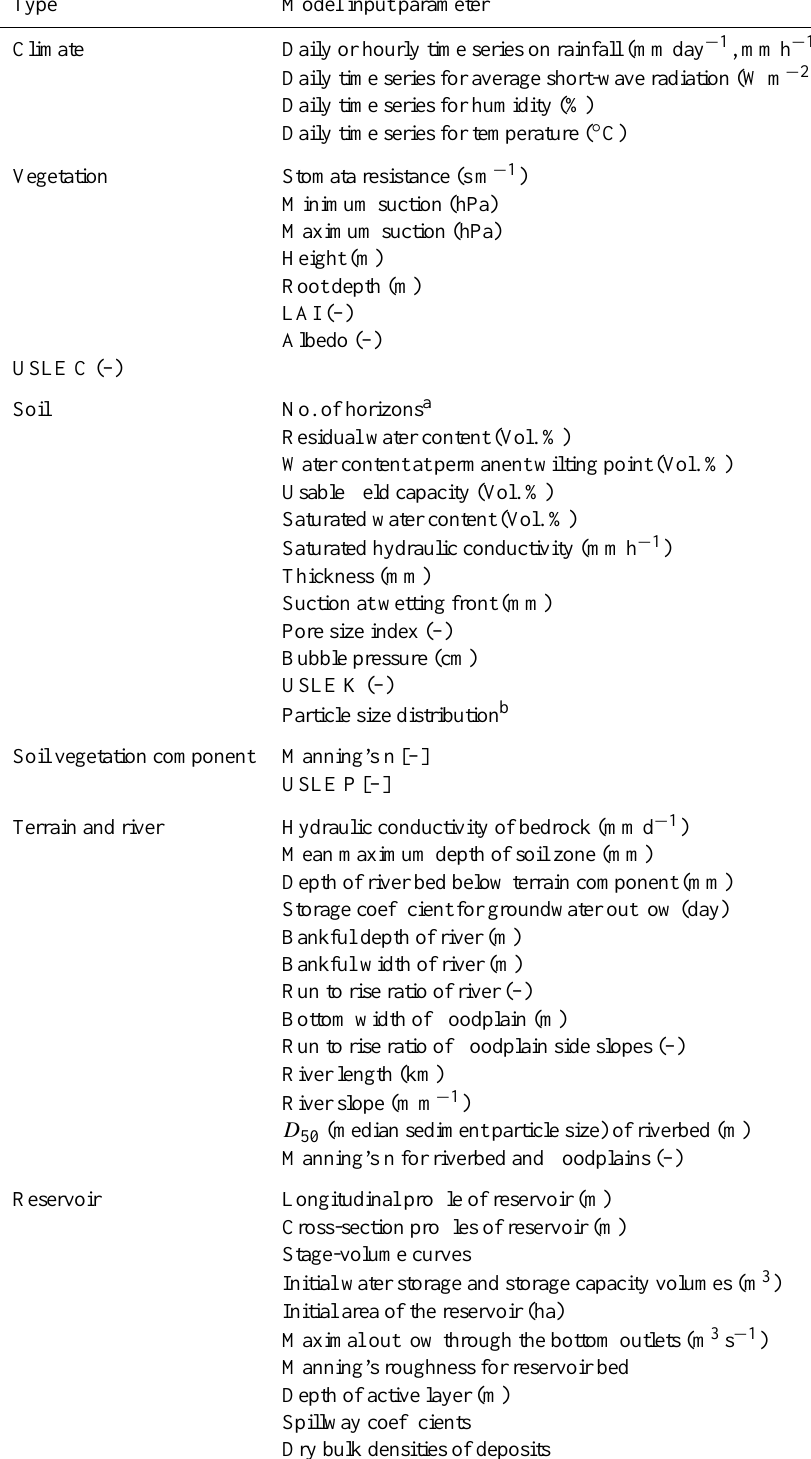
Table 3. Input data requirements for